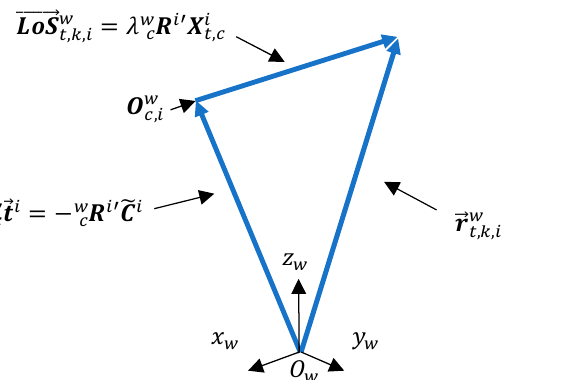
Figure 3. Camera optical center and LoS vector representation in the world coordinate system {W}.